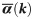
Average risk attitude α¯(k) in the rational (in blue), partially rational (in green) and irrational (in red) markets.